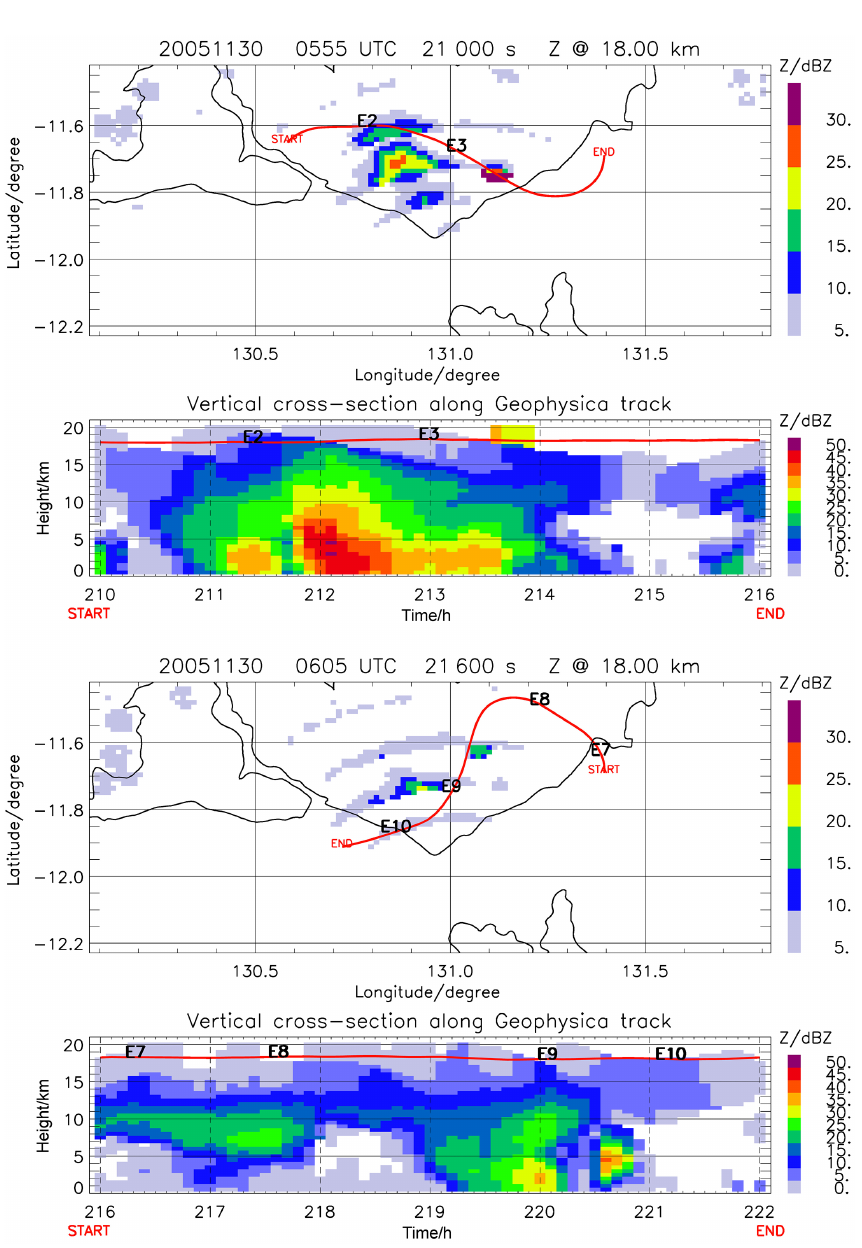
Figure 13. Radar reflectivity Z from CPOL (color scales in decibel dBZ) with the Geophysica flight path (red line) during a 600s time period centered at top: 05:55UTC (21000s, events E2 and E3) and bottom: 06:05UTC (20600s, events E7, E8, E9 and E10), 30 November 2005. Top panel: interpolated Z in a horizontal plane versus longitude and latitude at 18km altitude. Event positions and “START” and “END” of begin and end of the flight segment are identified. Bottom panel: interpolated Z versus altitude and time. The circular pattern in horizontal slices for low Z values and large distances reveals the radar observation pattern. The Z peak after E3 at 21340–21400s is caused by the